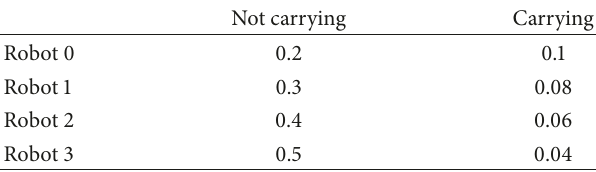
Table 8: Comparison between proposed method and full searching (with no unreasonable agents).